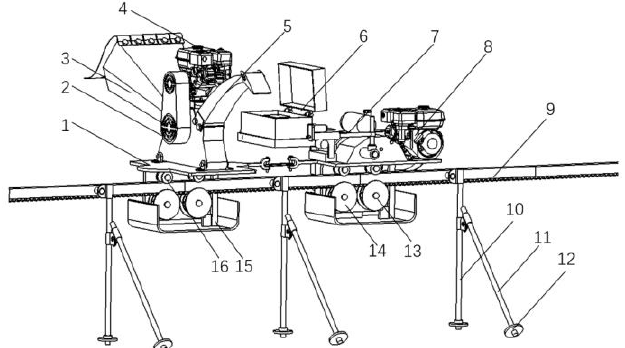
Figure 1. Overall structure of the self-propelled monorail branch chipper: 1. Chipper pallet. 2. Drive system of the chipper. 3. Feed channel. 4. Chipper engine. 5. Outlet. 6. Control box. 7. Control rod. 8. Traction engine. 9. Cross rail. 10. Main support rod. 11. Auxiliary support rod. 12. Pallet. 13. Drive wheel. 14. Guide wheel. 15. Protective frame for travel mechanism. 16. Load bearer wheel.